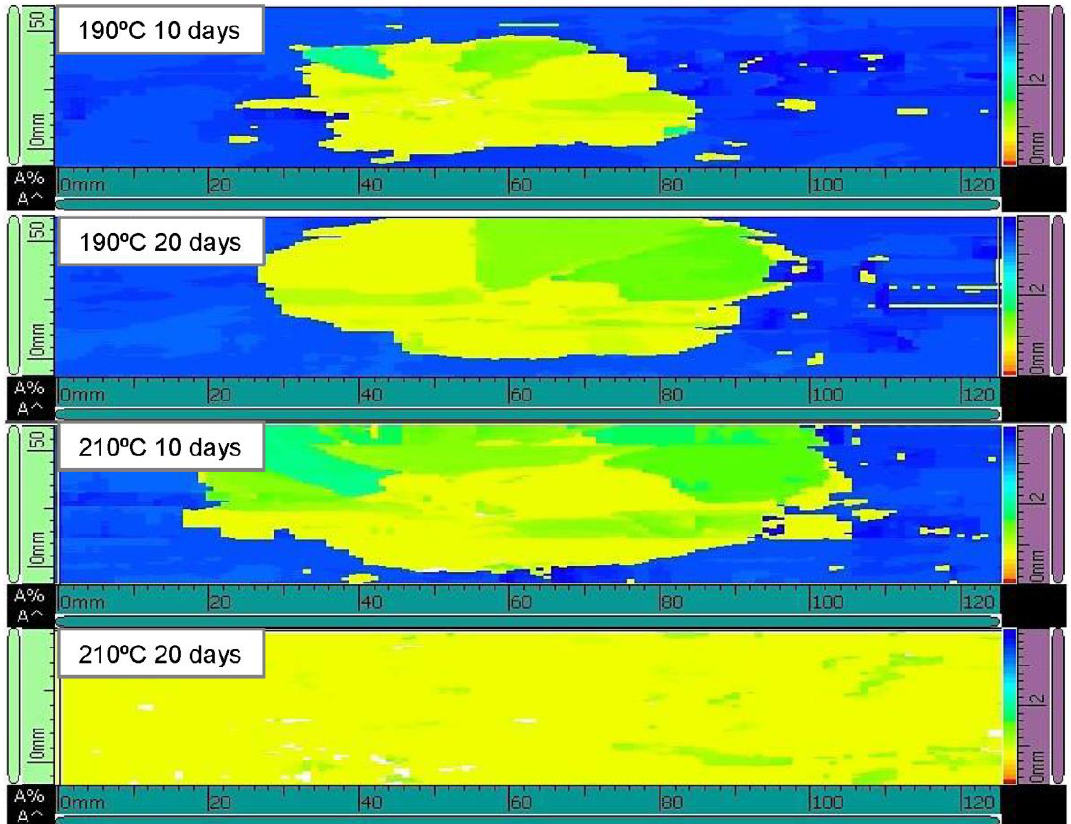
Figure 7. Ultrasonic C-scanning images of the damaged area of [0/90/ ± 45] 2s quasi-isotropic composite laminates aged at different temperatures and periods of time. The effect of ageing on the impact damage response. (E impact = 20J).